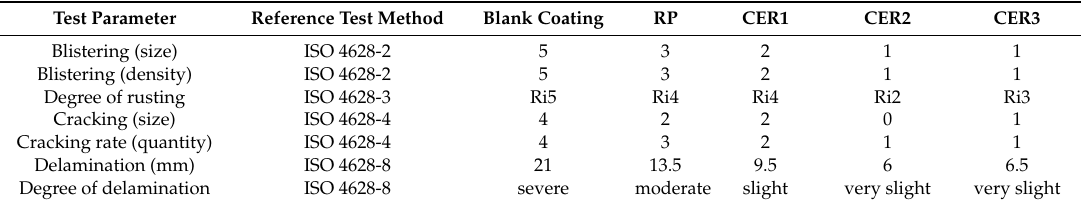
Table 6. Salt spray test results according to ISO 4628 (blistering, rusting, cracking, and delamination degrees) after 672 h corrosion cycles under 5% NaCl solution.